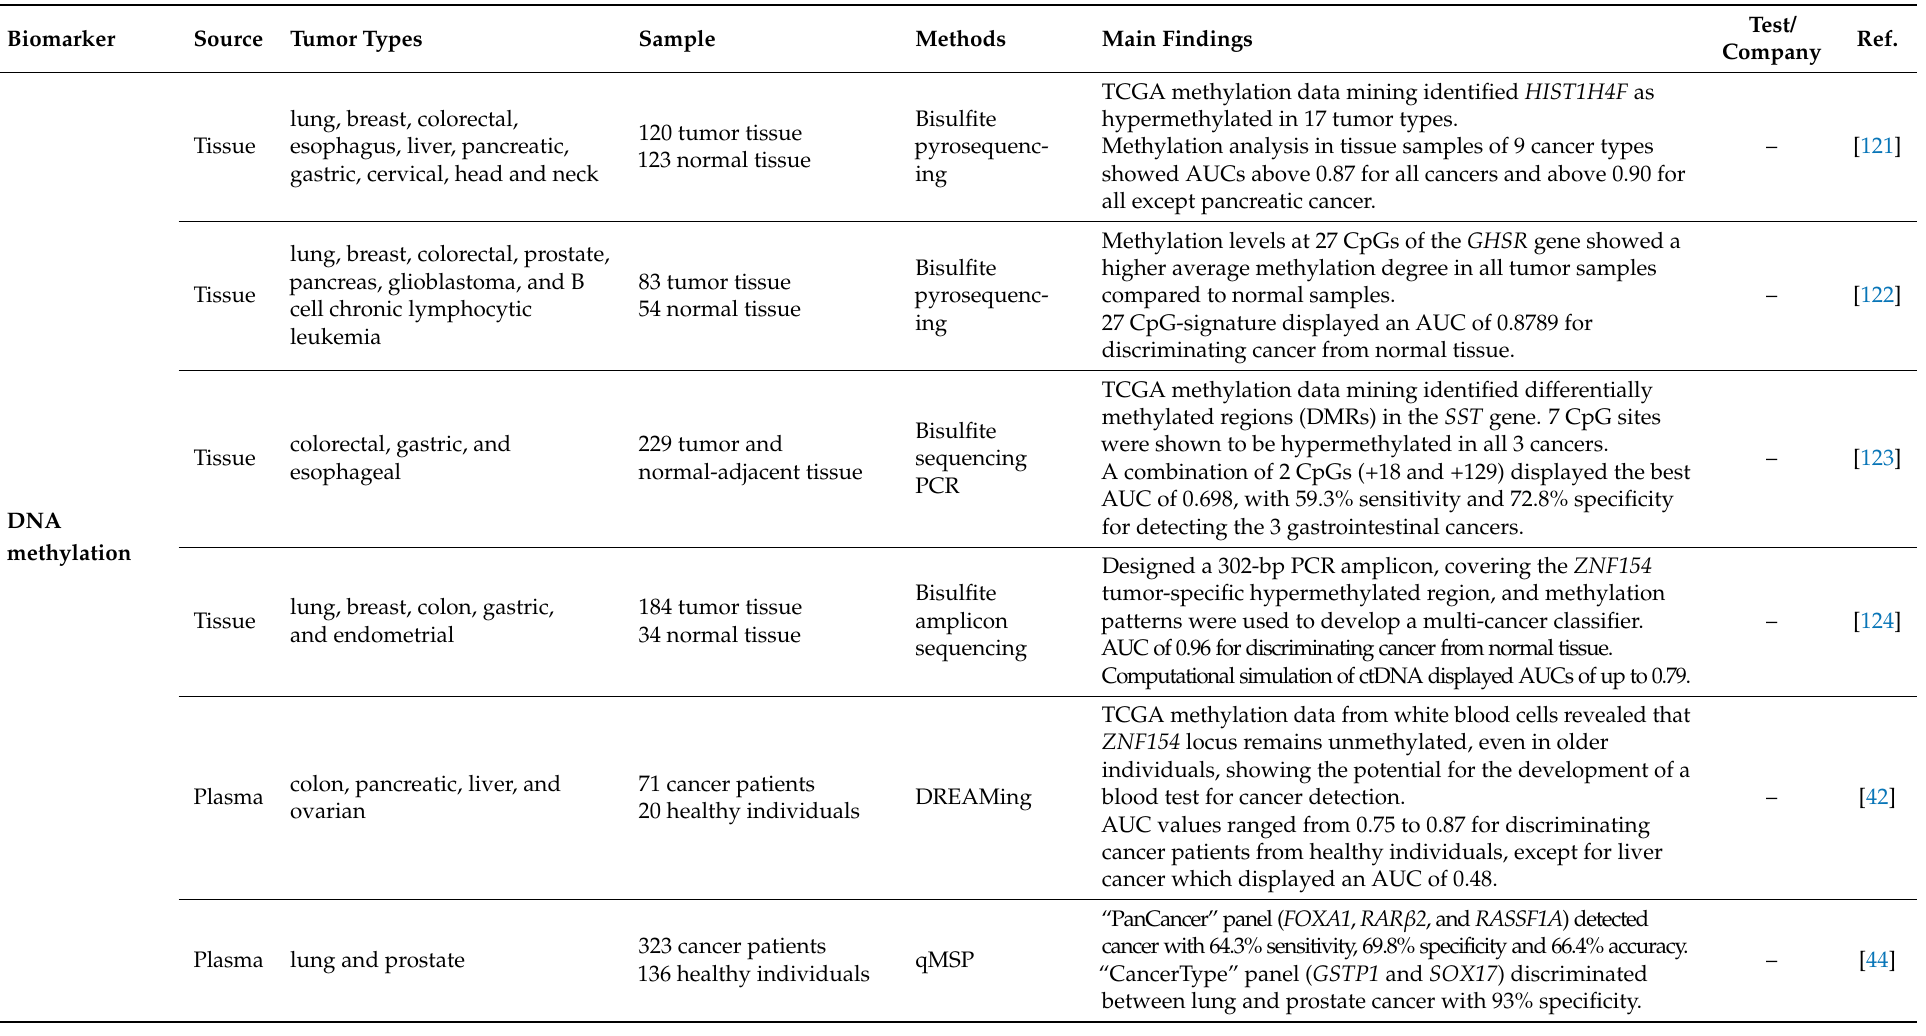
Table 1. Multi-cancer early detection tests validated on human